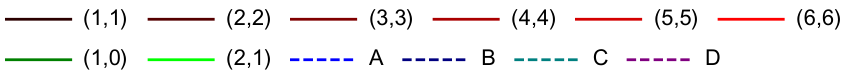
Figure 6. Legend for figures 7, 8, 9, 10, 11, and 12. The label ( n 1 , n 2 ) refers to the pincers of section 4.3.1; A, B, C, D are the four-center solutions of section 4.3.2.